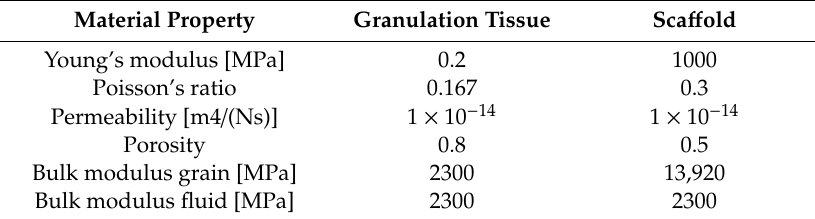
Table 2. Material properties utilized in the model of sca ff old and granulation tissue